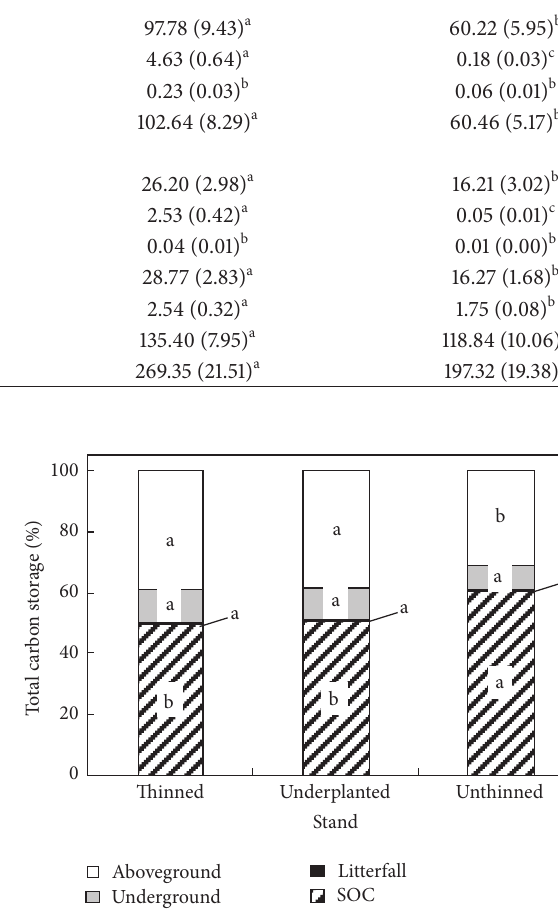
Figure 1: The percentages of vegetation aboveground/underground, litterfall, and soil carbon storage accounting for total stand carbon storage in the thinned, underplanted, and unthinned treatments; different letters in the same component indicate there are significant differences among the three treatments (5% level, Duncan’s